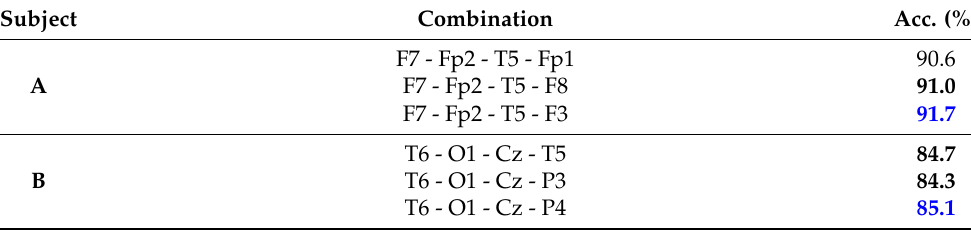
Table 7. Classification accuracies achieved for each 4-channel